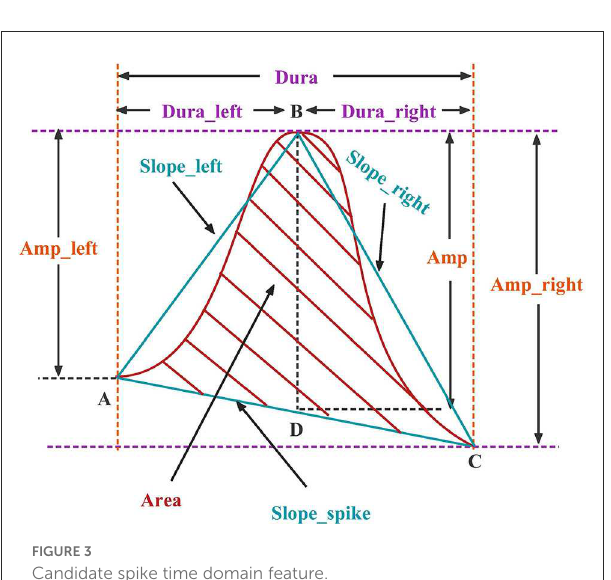
FIGURE3 Candidate spike time domain feature.